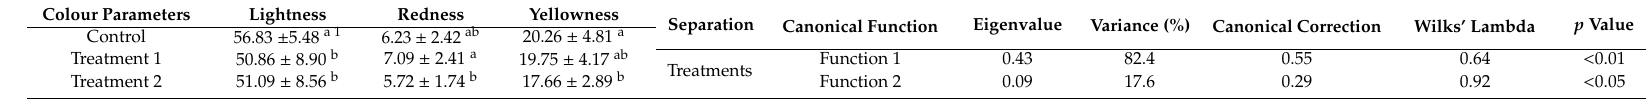
Table 3. Colour parameters of sausages with di ff erent types of casings and main statistics of the canonical discriminant functions from colour variables. Colour